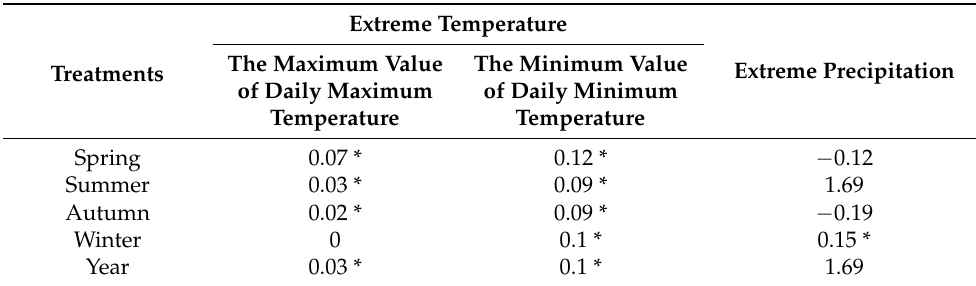
Table 3. Variation trends of extreme temperature and extreme precipitation in Henan Province from 1978–2021 under different time scales. The * represents passing the 0.05 significance